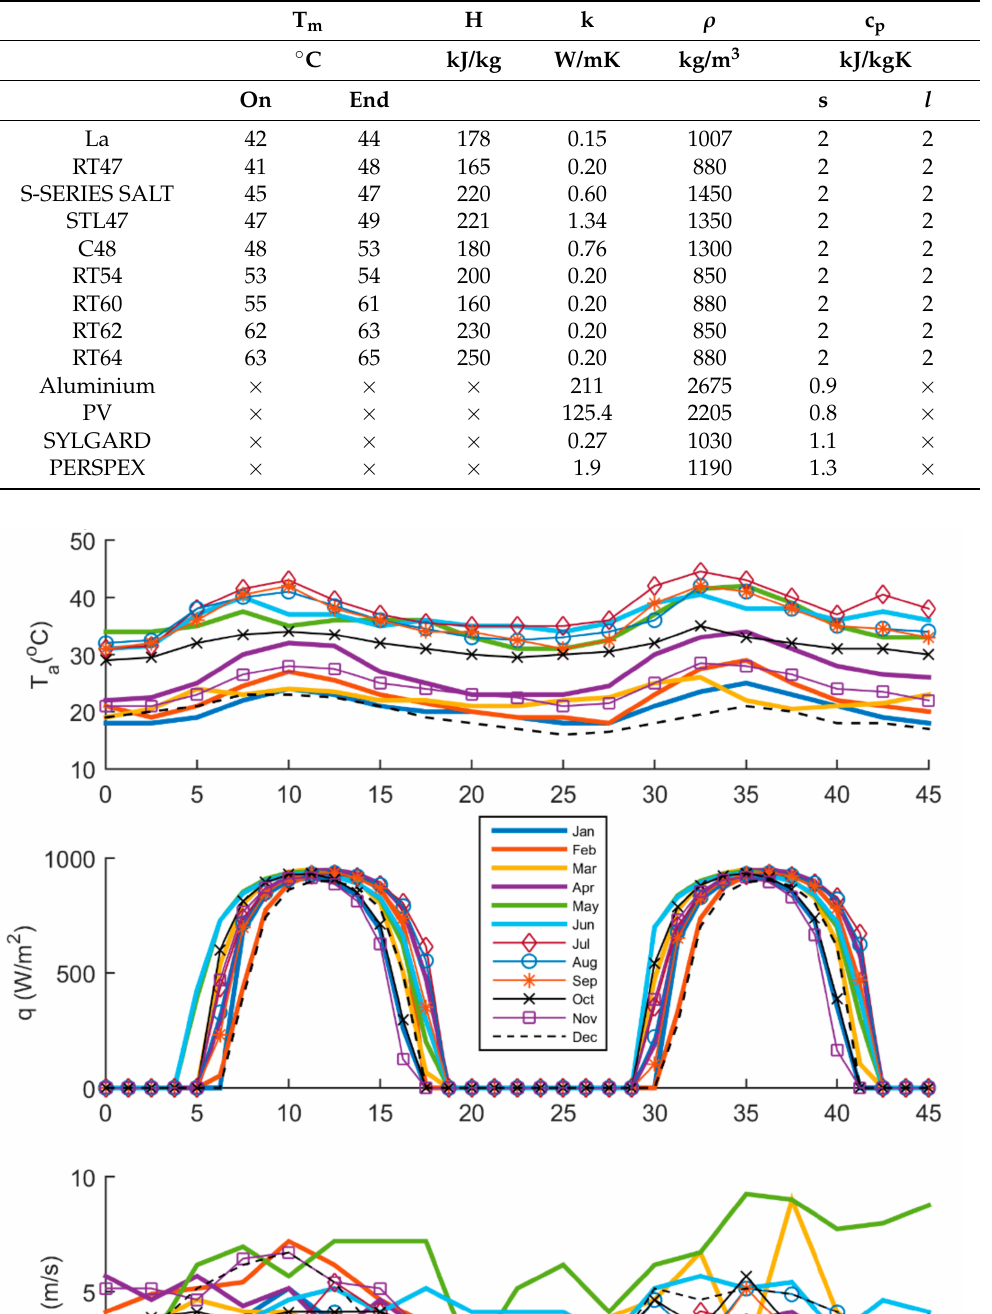
Table 1. Thermo physical properties of the phase change materials, Aluminum, photovoltaic and